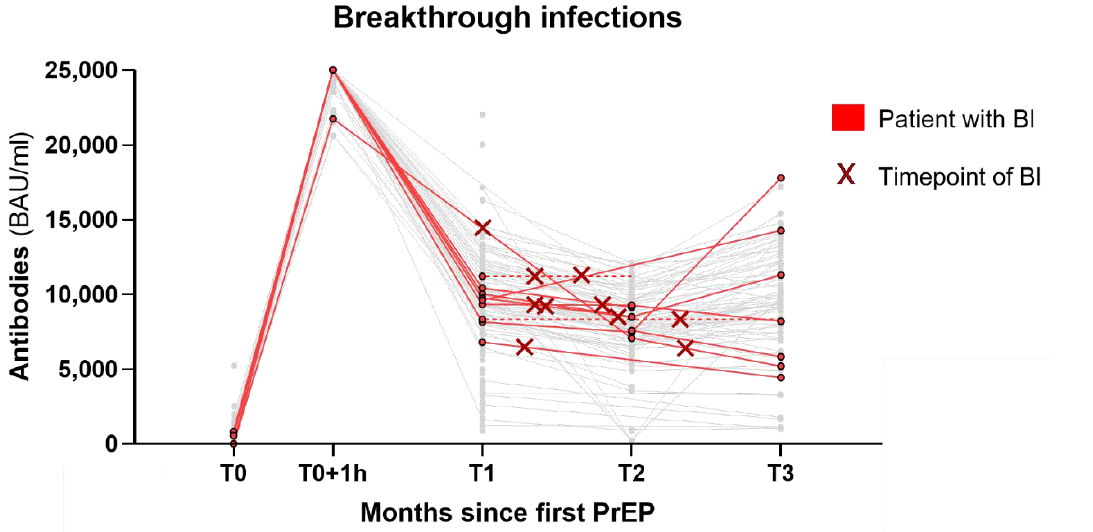
Figure 3. Graph of the BIs that occurred. Each red line represents a patient with BI while all patients without BI are greyed out. The time point of BI is highlighted with a red cross. The dotted lines are projections of the last available values for patients with missing follow-up measurements. Three patients with BI are not represented in this graph due to missing antibody values. BI = breakthrough infection; PrEP = pre-exposure prophylaxis; BAU = binding antibody units; mL = milliliter; T0 – T3 = time points of measurements, roughly equal to months since first PrEP.